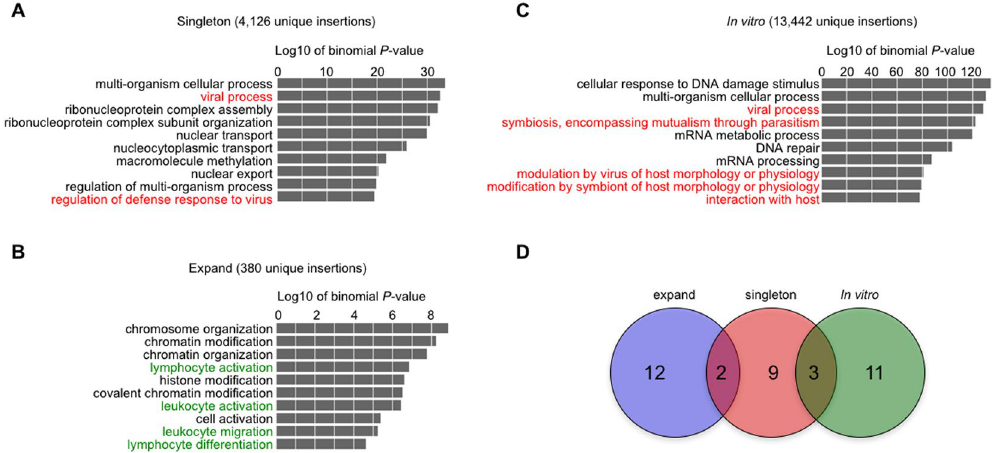
Figure 5. Gene ontology enrichment analysis of HIV-1 integration sites. ( A , B ) GO enrichment analysis of the HIV-1 integration sites in singleton ( A ) and expanded clones ( B ). ( C ) The GO enrichment analysis for in vitro integration sites is shown as a control. The numbers above the graphs represent – log10 of binomial P -value. There were 69, 14, and 105 GO terms enriched significantly in singleton clones, expanded ones, and in vitro infection, respectively. Term names shown in red and green are associated with “Host-pathogen interaction” and “leukocyte and lymphocyte activation”, respectively. ( D ) Venn diagrams showing the similarities and differences of enriched GO terms between each data set. For comparison, top 14 term names were selected from each data set.